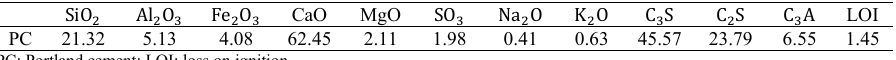
Fig. 1. Global cement production versus year, extracted from Mendes literature [2]. Table 1. Chemical compositions of PC obtained by using XRF analysis (% by weight).